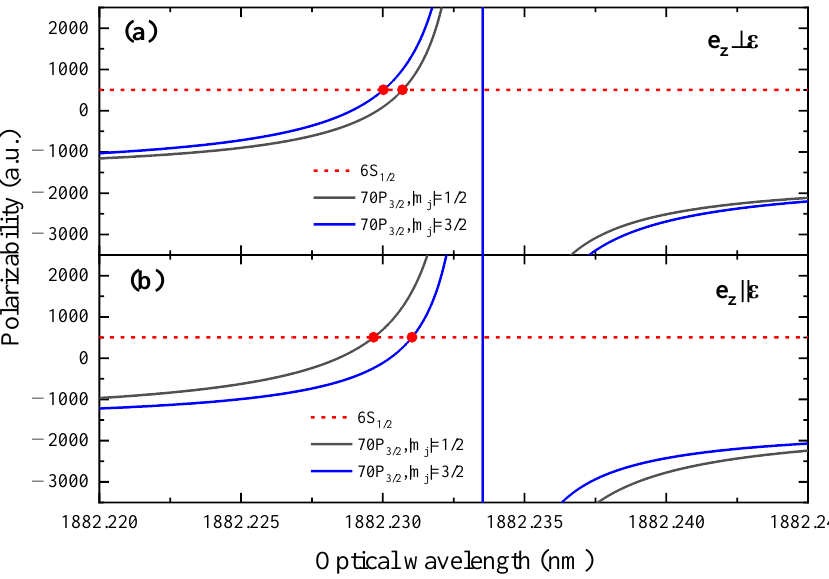
Figure 4. The dynamic polarizabilities of the ground state and the Rydberg state in the case of linearly polarized light in the range from 1882.220 to 1882.245 nm near the auxiliary transition of 70 P 3/2 ↔ 7 D 5/2 . ( a ) The quantization axis is perpendicular to the plane of polarization and ( b ) the quantization axis is parallel to the plane of